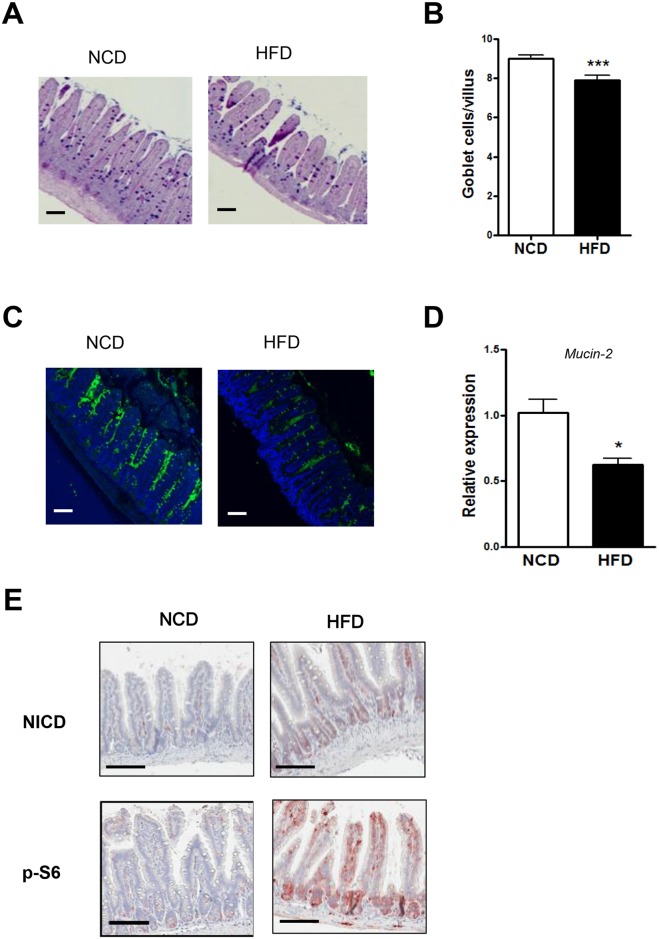
Decrease of goblet cells in mice fed a high-fat diet (HFD).(A and B) Changes in goblet cells in HFD-fed mice. Representative PAS/Alcian blue-stained sections of the distal ileum from NCD- or HFD-fed mice showing goblet cells (blue) (A) and quantification of goblet cell number (n = 5 each) (B). (C and D) Changes in Mucin-2 expression. Confocal microscopic images of the distal ileum following immunofluorescence staining using anti-Mucin-2 mAb (C) and relative expression of Mucin-2 determined by RT-qPCR (n = 5 each) (D). (E) Immunohistochemistry using anti-Notch intracellular domain (NICD) and phospho-S6 Abs. Original magnification for all images is ×100, except (E) (×200). Scale bar, 100 μm. All values are expressed as the means ± SEM. A student’s t-test was used to compare values between two groups. *P < 0.05 and ***P < 0.001.